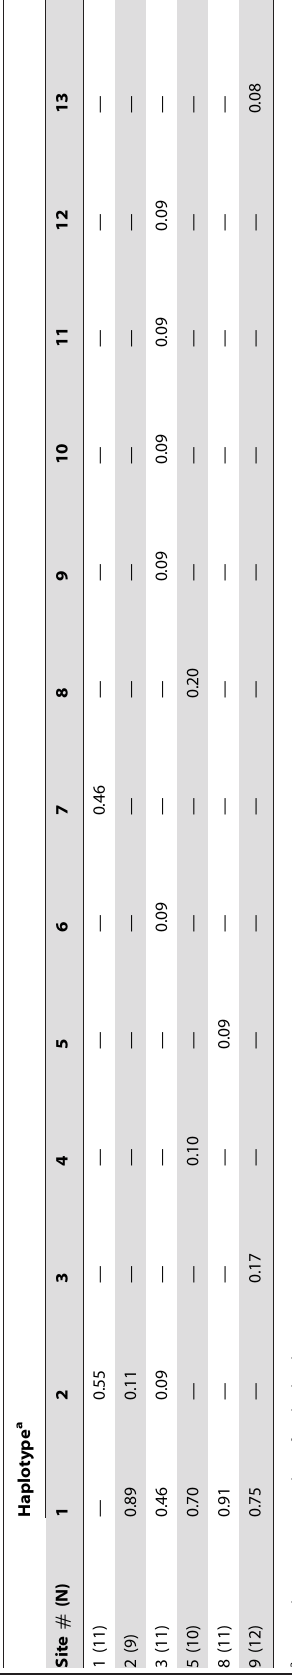
(A), and inbreeding coefficients (F). We subsequently performed multiple runs with different seeds to insure comparable results were obtained between runs. We ran 10 7 iterations, with 10 6 as burn-in, with a sampling interval of 10 3 . Mixing parameters were dM= 0.1, dA = 0.45, and dF = 0.45. We examined the trace outputs of the log-probabilities to insure the MCMC had converged using the program T RACER (v.1.6.0 [59]). Estimates of ancestry for each individual were summarized by adding the estimated ancestry coefficients (source, 1 st generation or 2 nd generation migrant from each population) to characterize the likelihood of migrant ancestry.